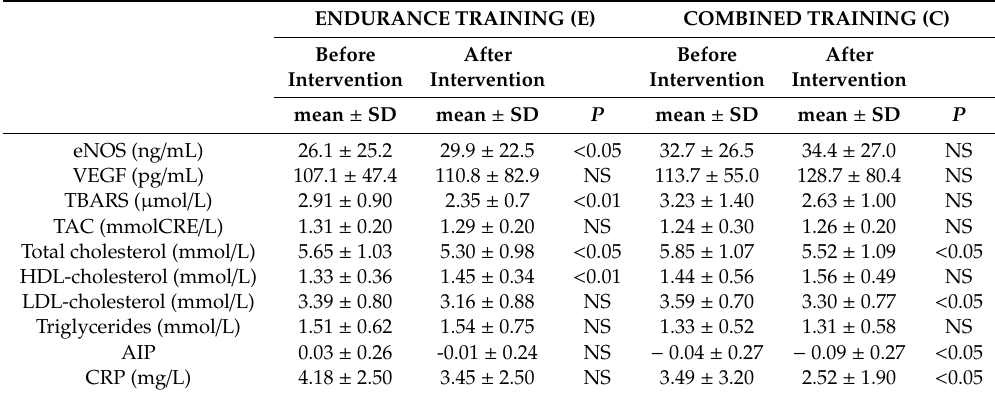
Table 2. Biochemical parameters of E and C groups before and after a 3-month training